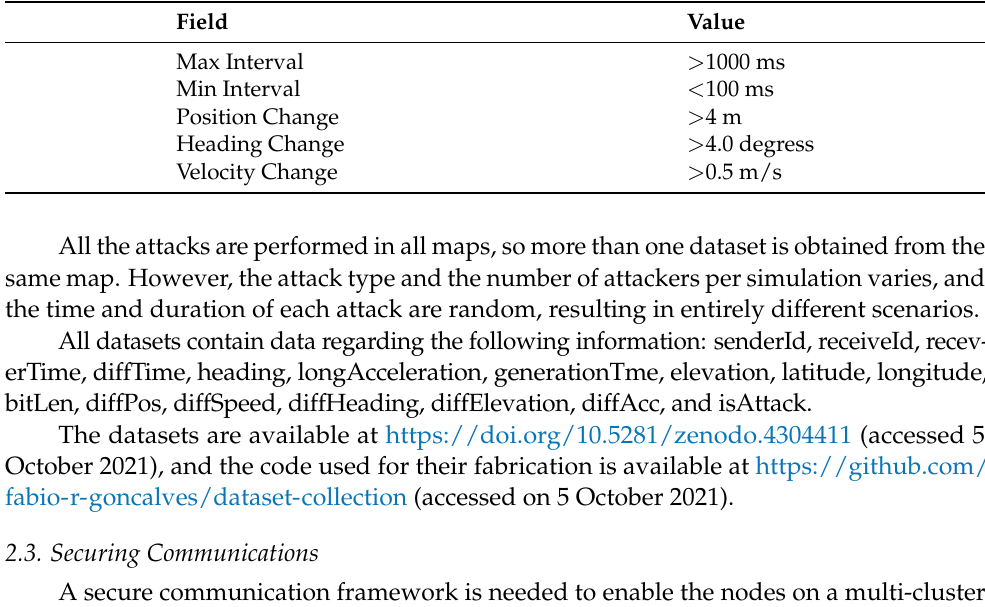
Table 2. CAM generation parameters—EN 302 637-2 [34]. Field Value Max Interval > 1000 ms